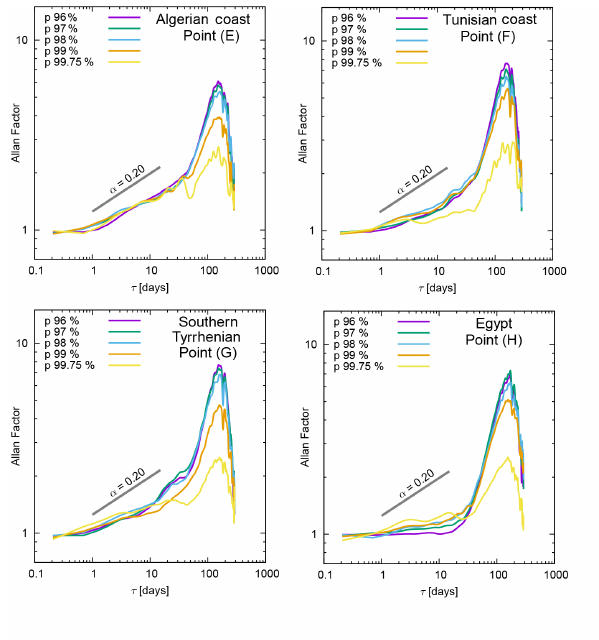
Figure 9. Allan factor (AF) as a function of counting window τ and of the wave height threshold (different percentiles as in the legend) for different locations in the Mediterranean Sea (cf. Fig.